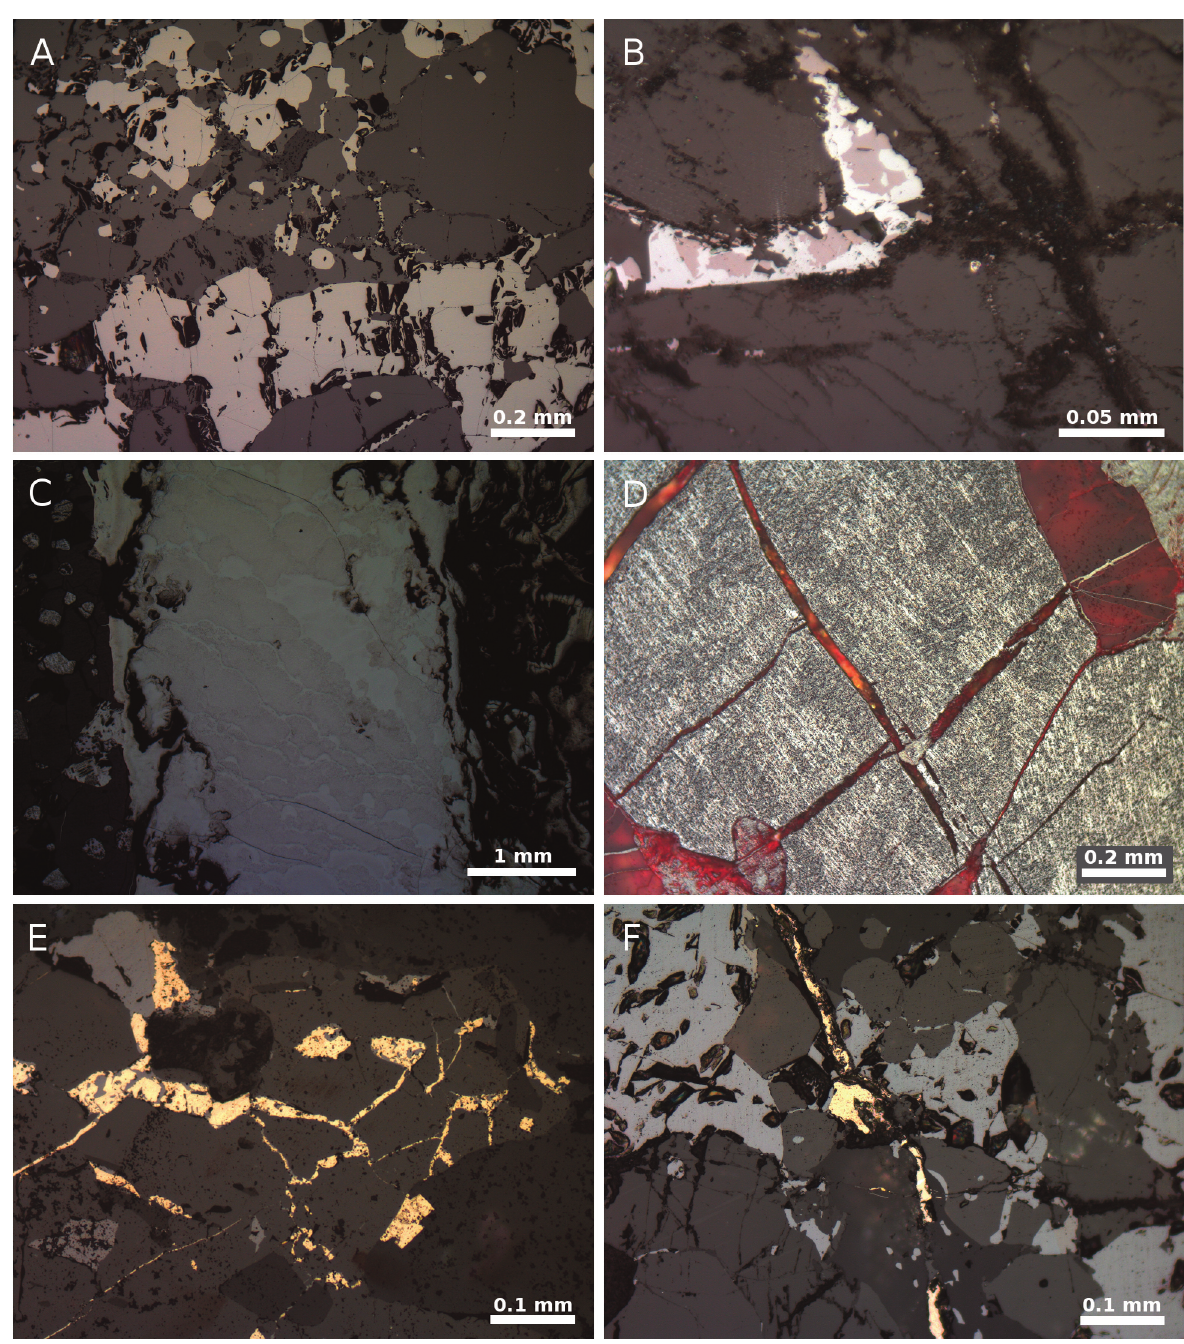
Fig. 4. A , anhedral and elongated magnetite grains (light grey) and rounded inclusions of magnetite embedded in silicate minerals (dark grey). Plane­polarized light. Drill core F­1, depth 317.0 m. B , subhedral magnetite grain (pinkish­grey) partly altered into hematite (white) along edges, cracks and cleavage planes. Plane­polarized light. Drill core 315, depth 298.0 m. C , a subparallel hematite vein with colloform internal structure (light grey, centre), colloform earthy hematite layering (dark, right) and altered subhedral magnetite grains (medium grey, left). Plane­polarized light. Drill core F­9, depth 255.8 m. D , a magnetite grain showing alteration into anisotropic hematite (light grey) as thin lamellae or dust­size spots. Cross­polarized light. Drill core F­9, depth 255.8 m. E , magnetite (light grey) and pyrite (yellow) filling brittle fractures at granitic vein tip (dark grey, lower right). Plane polarized light. Drill core J­1, depth 444.4 m. F , pyrite (yellow) appears as late fracture filling cross­cutting magnetite­rich (light grey) gneiss layering. Plane­polarized light. Drill core J­2, depth 710.0